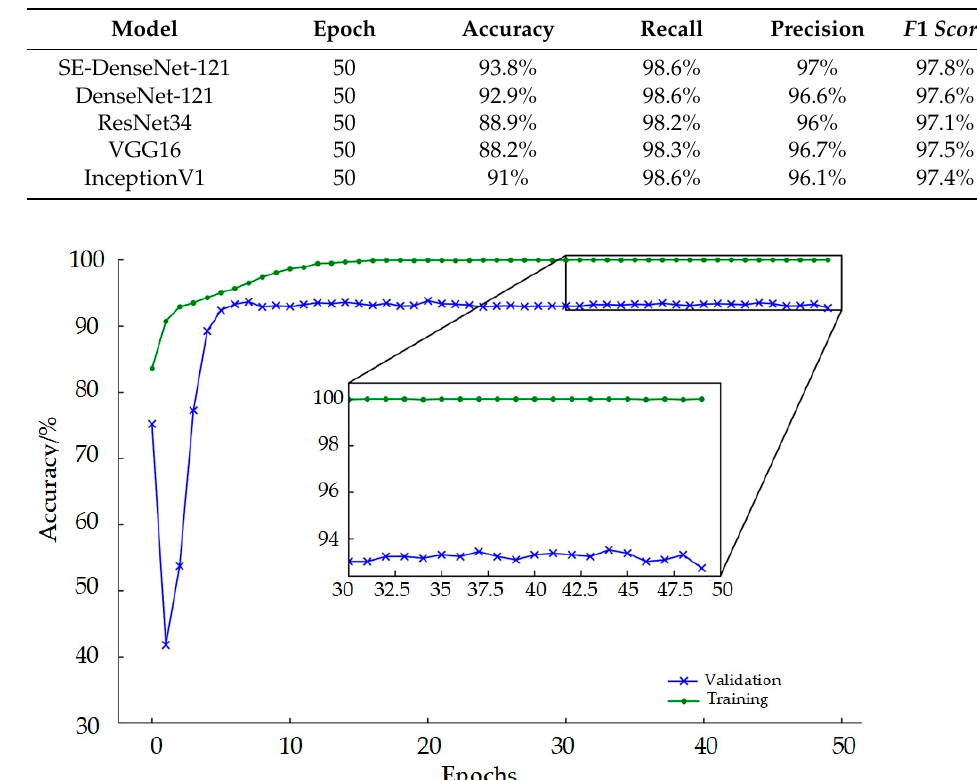
Figure 12. Comparison of training and validation accuracy curve changes. The MFCC + ∆ MFCC parameters were taken as the model input, and the recognition accuracy, recall, precision and F1 score were taken as the evaluation indexes on different recognition models. The performance of the model was tested using 50 epochs of training iterations. The experimental results of pig cough sound recognition via different models are shown in Table 5. Table 5. Performance comparison of different models.